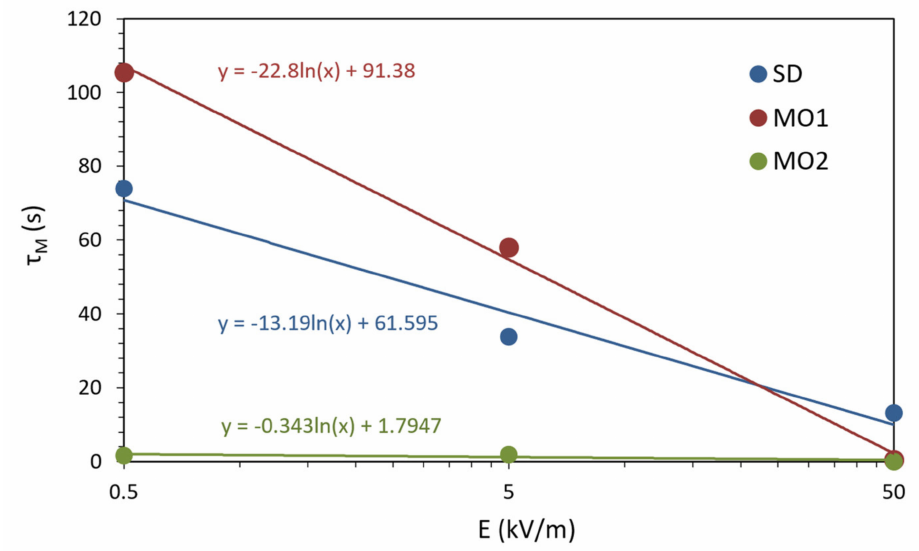
Figure 12. Regression lines of relaxation time τ M depending on the intensity E of the time-varying electric